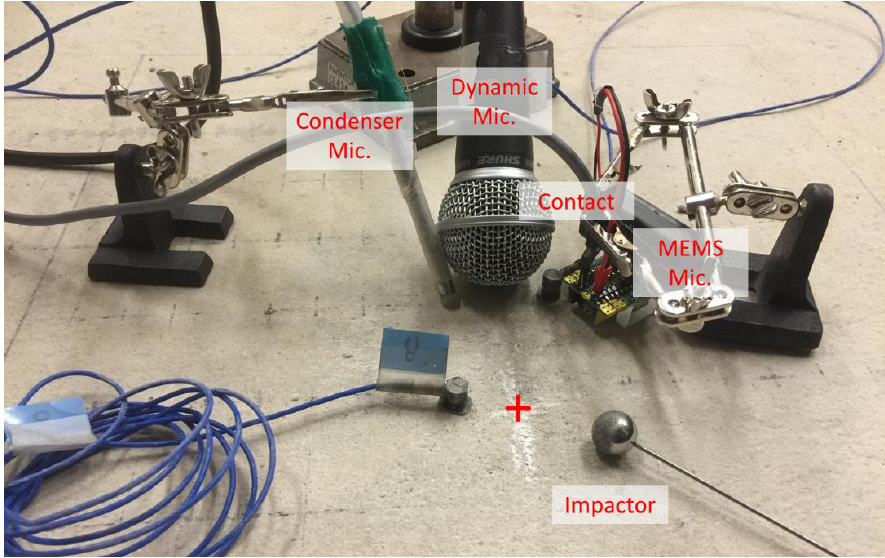
Figure 5. Impact echo test configuration showing three air-coupled sensors and contact sensor above the delamination